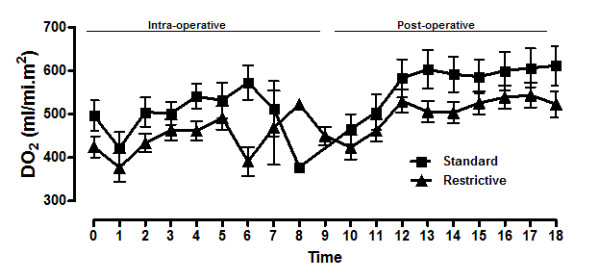
Temporal patterns. Temporal patterns of oxygen delivery (DO2) during surgery and postoperatively for the restrictive group (black triangles) and the conventional group (black squares). The results are presented as means and standard errors of the mean. 0, preoperative; 1, 30 minutes intraoperatively (IO); 2, 60 minutes IO; 3, 120 minutes IO; 4, 180 minutes IO; 5, 240 minutes IO; 6, 300 minutes IO; 7, 360 minutes IO; 8, 420 minutes IO; 9, 480 minutes IO; 10, ICU admission; 11, 1 hour postoperatively (PO); 12, 2 hours PO; 13, 3 hours PO; 14, 4 hours PO; 15, 5 hours PO; 16, 6 hours PO; 17, 7 hours PO; 18, 8 hours PO. Treatment × time interaction; P < 0.0001.